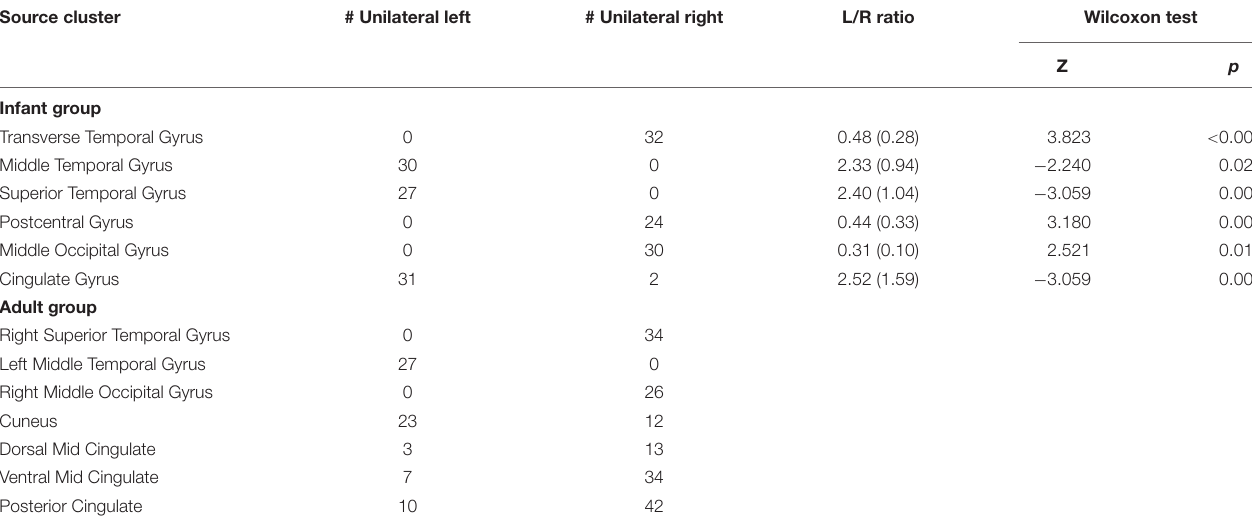
Statistics and p-values for the Wilcoxon test performed on left and right dipole moment magnitudes (upper panel). The number of the left and right unilateral ICs contributing to each similarly located cluster in the adult group (lower panel). No L/R ratio was reported for the adult clusters due to the low number of bilateral ICs in each cluster.